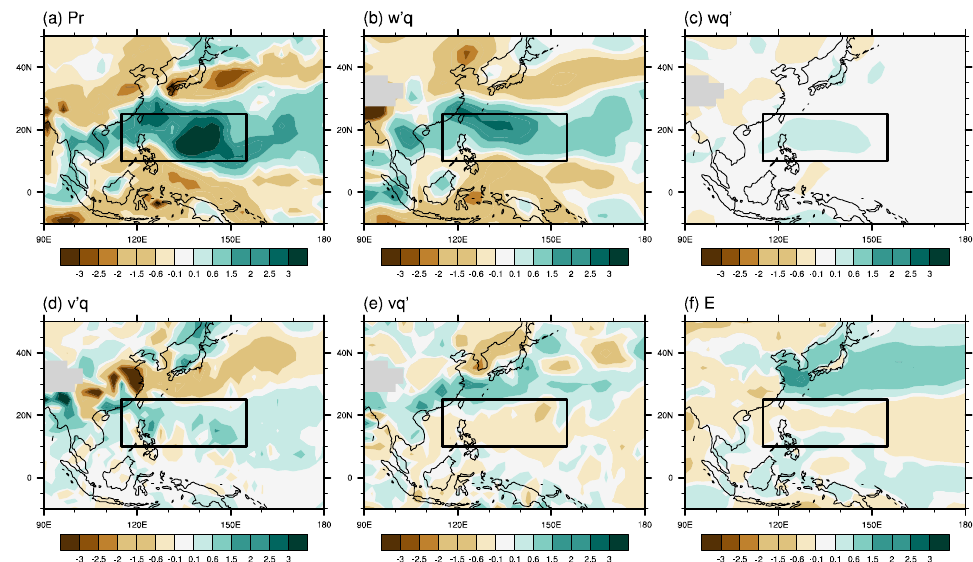
Figure 4. Climatological surface flux change in ( a ) shortwave, ( b ) longwave, ( c ) latent, and ( d ) sen- sible heat from July to August (units: W/m 2 ). The change means the difference between August and July. The black box denotes the region mainly focused on in this study (10–25° N, 115–155° E).